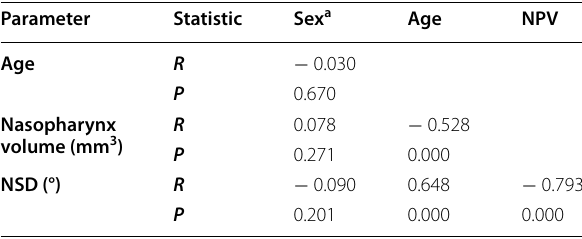
Table 3 The results of the Pearson and point-biserial correlation coefficients (n for each coefficient =